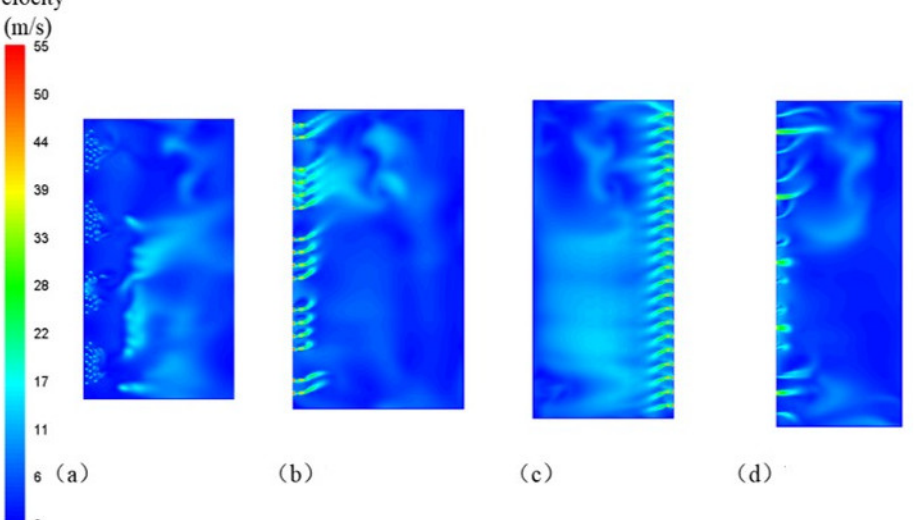
Figure 3. The velocity distribution of the grate tail section in 0 working condition. ( a ) Lower secondary air on front wall; ( b ) Middle secondary air on front wall; ( c ) Secondary air on back wall; ( d ) Upper secondary air on front wall.